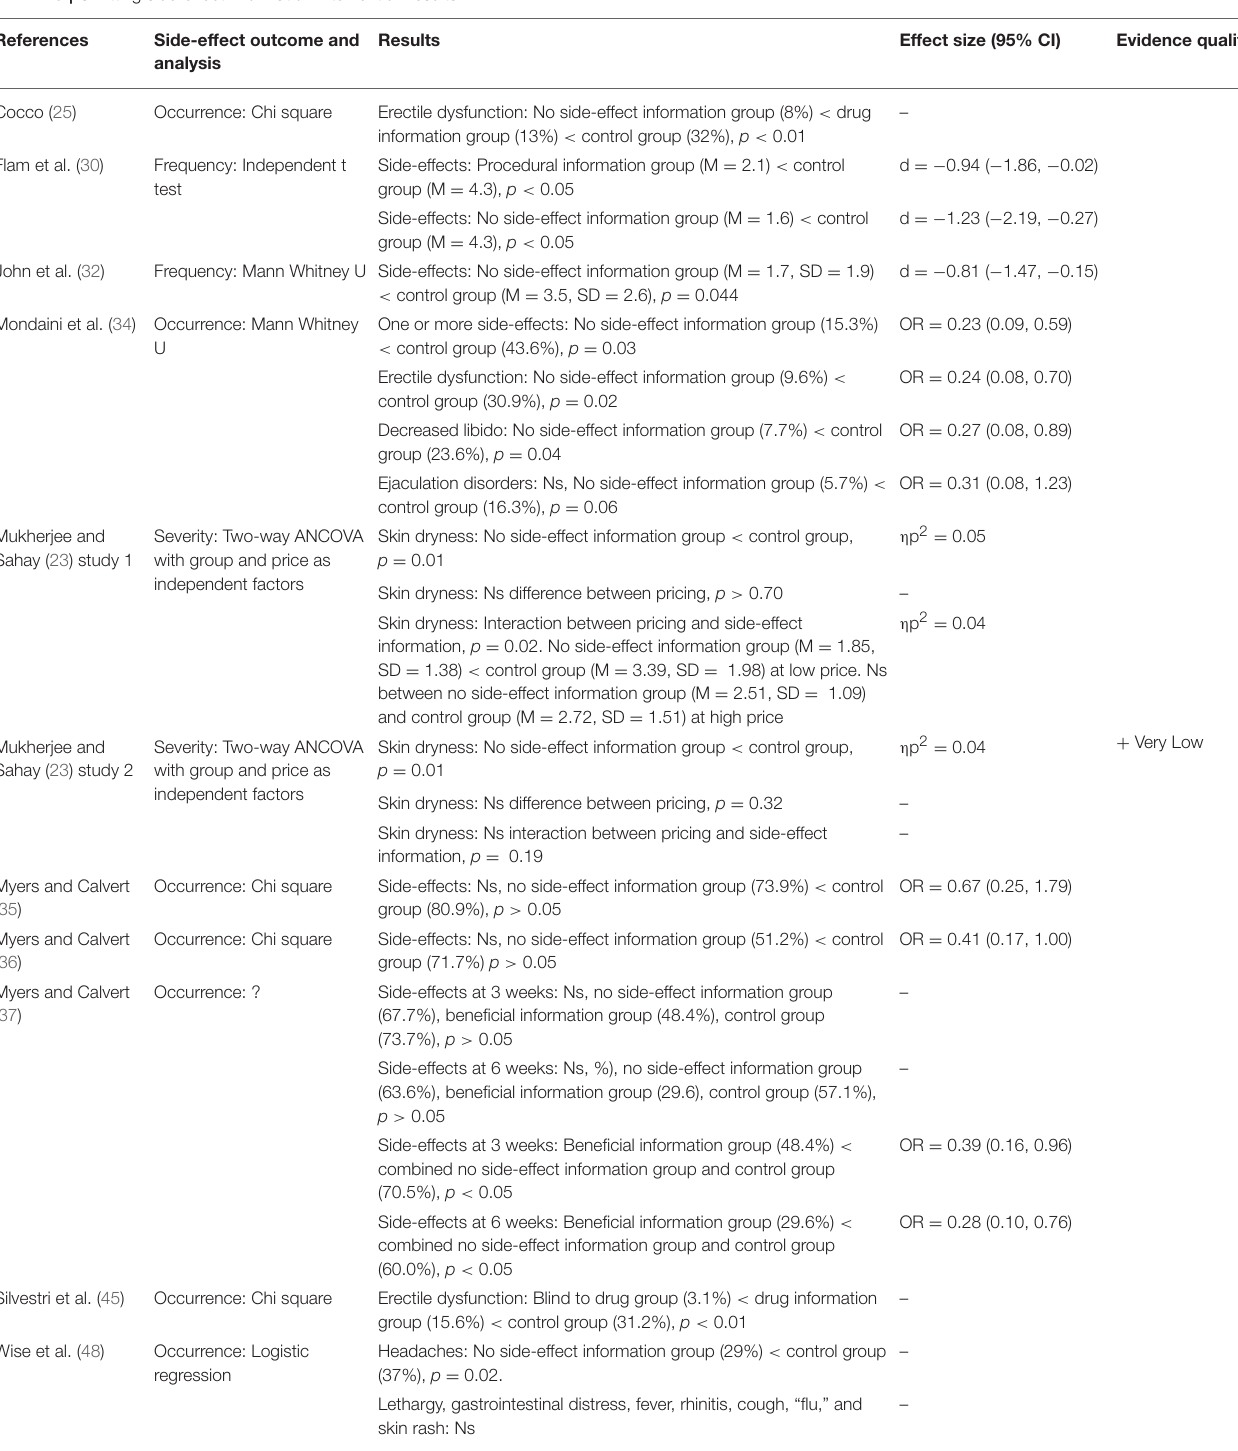
TABLE 5 | Omitting side-effect information intervention